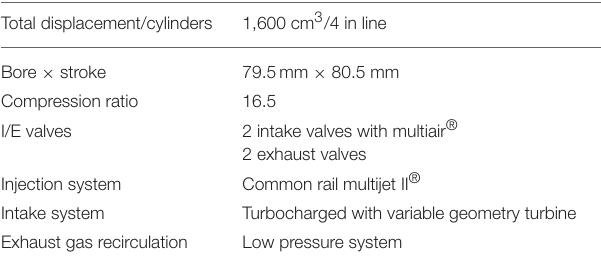
TABLE 3 | Main technical data of the considered diesel